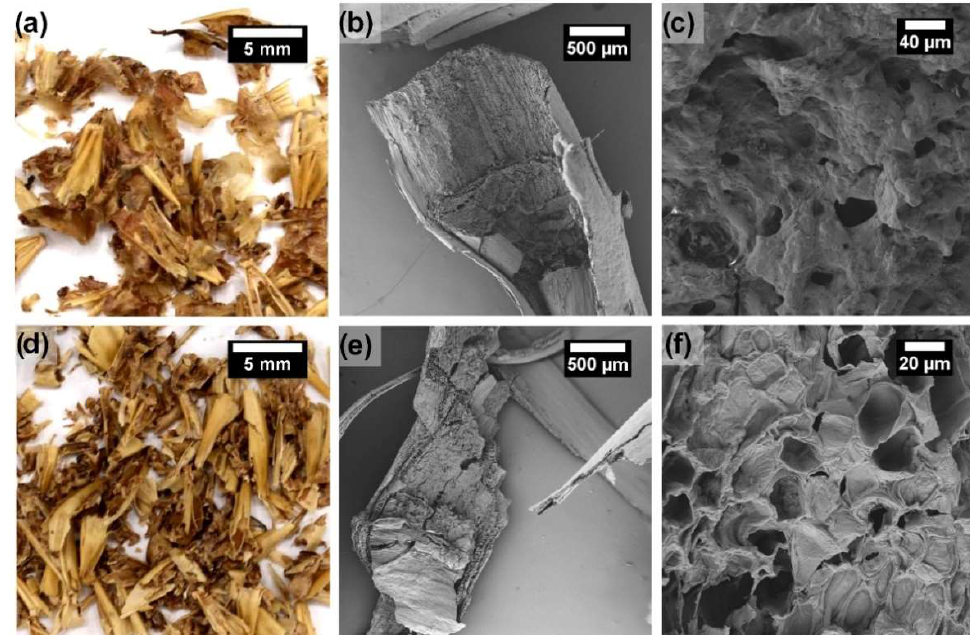
Figure 3. Images of WB-BSG (top row) and H-BSG (bottom row) at different magnifications ( a ) and ( d ) from conventional SLR camera; ( b – f ) SEM images of two different magnifications. SEM-EDX micrographs (Figures S3–S5) affirm the morphological heterogeneity of To investigate the specific surface area of the material, N 2 and CO 2 sorption measure- the BSG. The performed elemental mapping only represents sections of individual parti- ments were conducted. The BET fitting did not indicate any noteworthy pores in the micro or mesoporous range in the material (see Figures S1 and